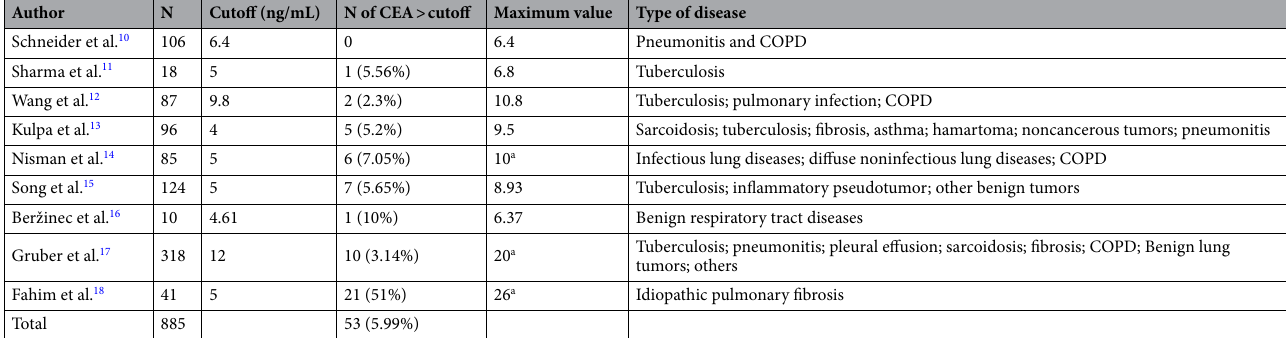
Table 3. Summary of CEA levels in benign lung diseases reported in the literature. COPD Chronic obstructive pulmonary disease. a Approximate